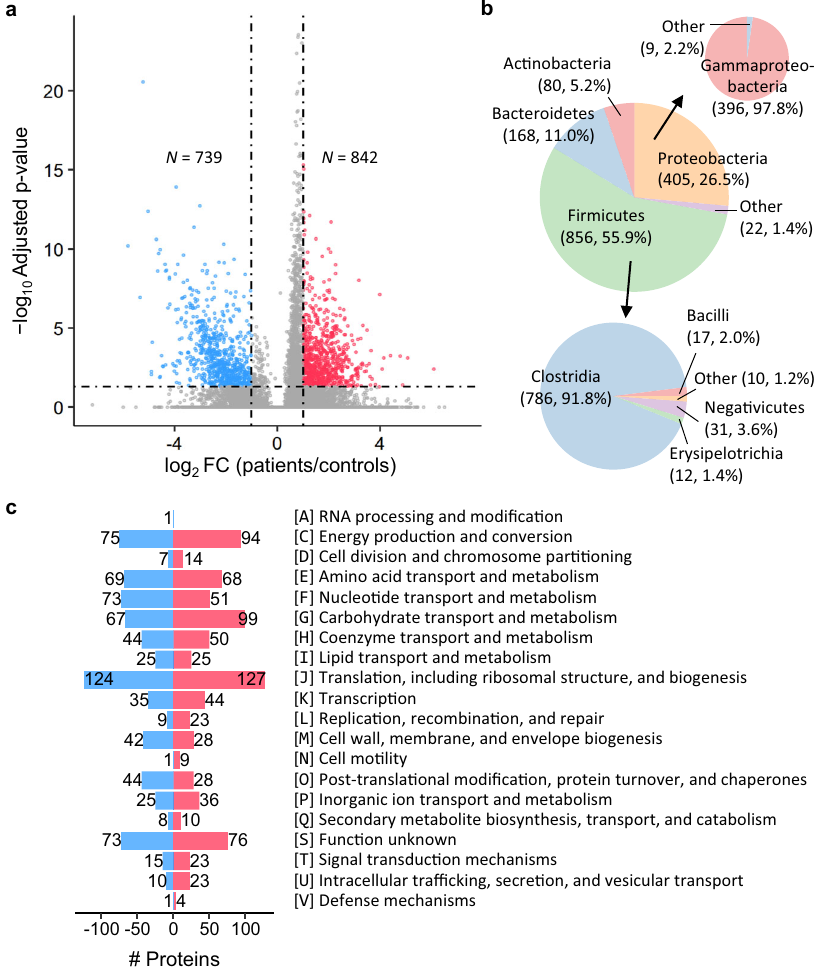
Fig. 4 Differential gut microbial proteins between the MCI patients and controls. a Volcano plot indicating the differential proteins between the patients and controls. Proteins with fold change (FC, patients/controls) > 2 and p-value < 0.05 were colored red, while those with FC < 0.5 and p -value < 0.05 were colored blue. The p-values were given by MS1-MS2-combined statistical test in Spectronaut and adjusted by the Bonferroni method. b Distribution of taxonomy assigned to the differential proteins. c Numbers of the differential proteins in each category of clusters of orthologous groups (COG). Proteins more abundant in patients were colored red, while those more abundant in controls were colored